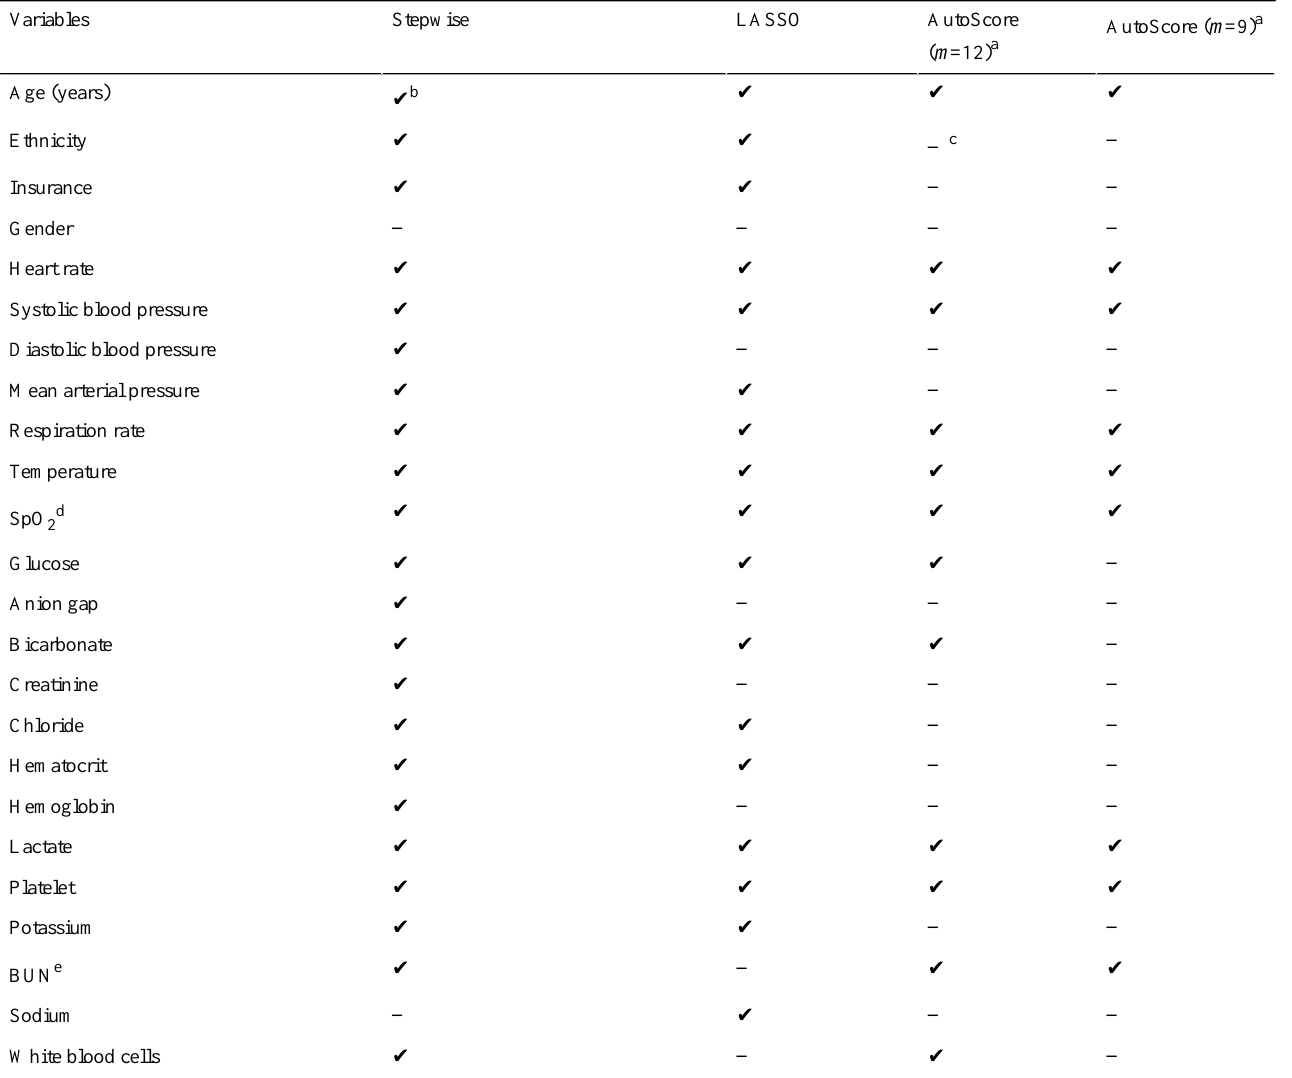
Table 3. Selected variables by AutoScore and other baseline